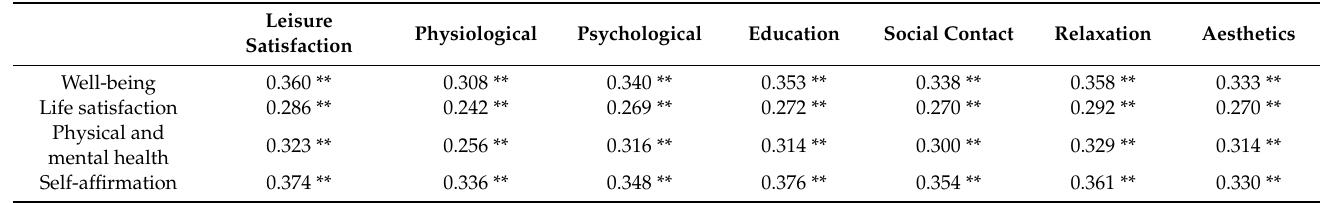
Table 5. Correlation analysis of environmental experience value, leisure involvement, leisure satisfac- tion, and well-being (leisure satisfaction and